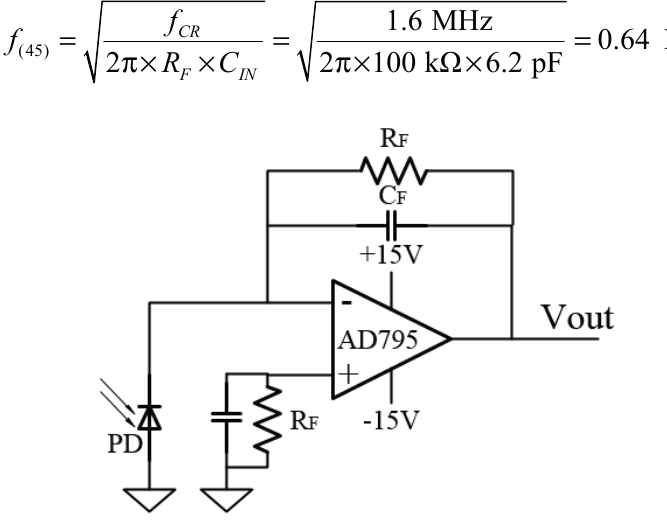
Figure 8. Schematic diagram of the I/V